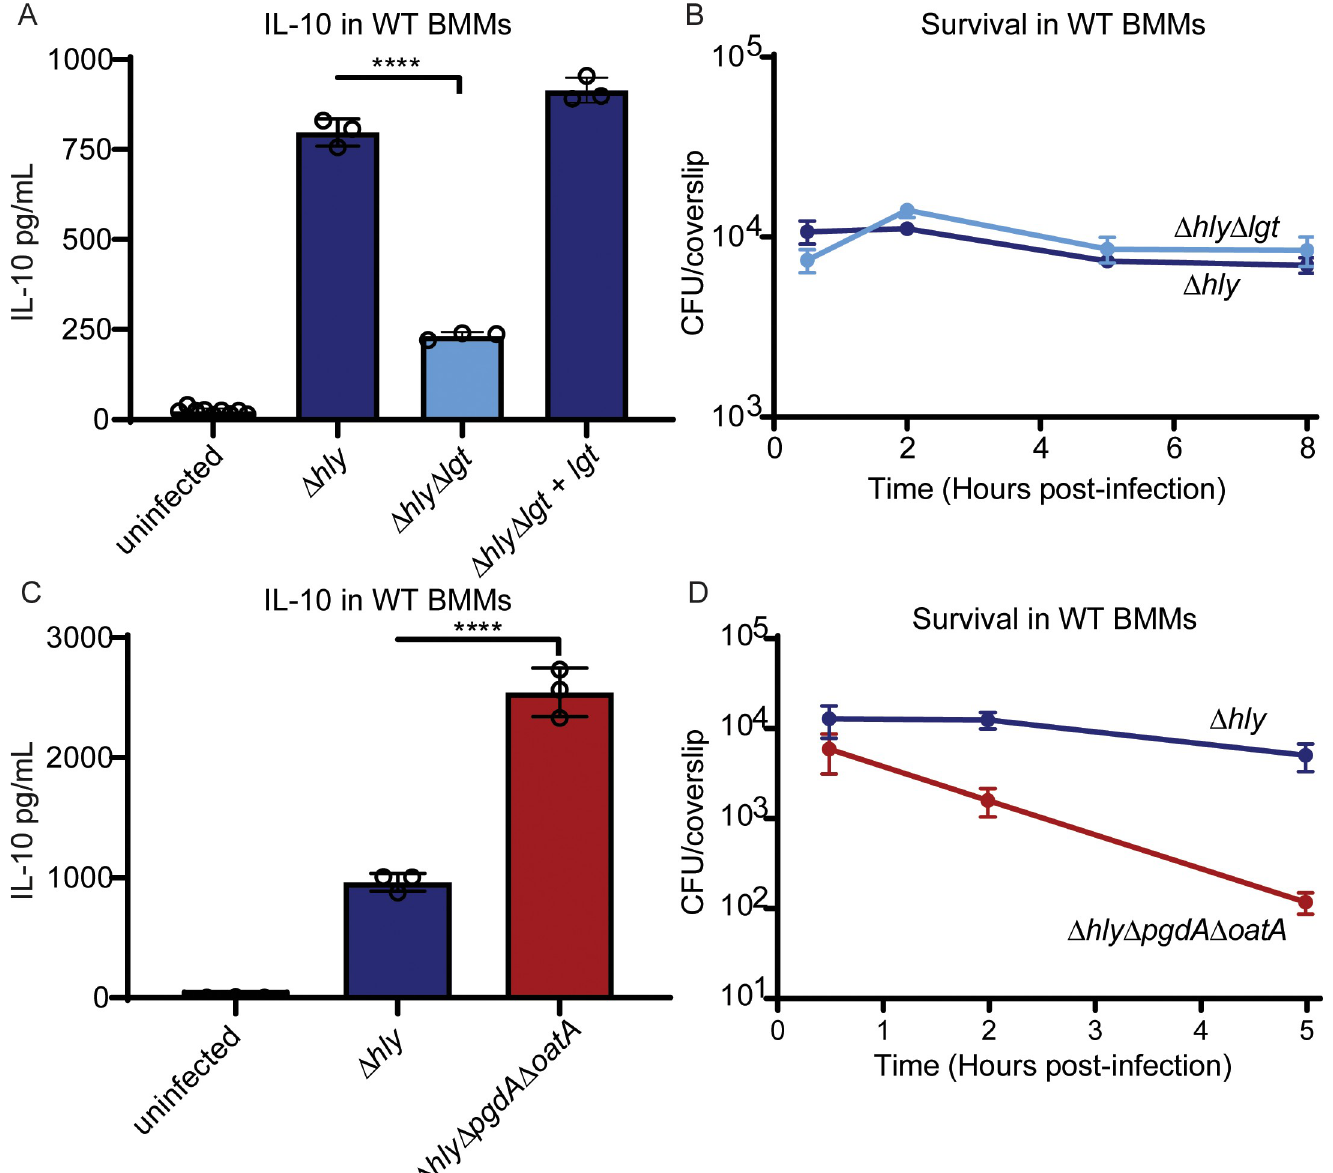
Fig 2. Induction of IL-10 is mediated by lipoproteins and bacteriolysis. (A) IL-10 secretion from BMMs four hours-post infection. Mean and SD are shown. Data are representative of two independent experiments. Data analyzed using Holm-Sidak’s multiple comparison’s test. (B) Survival of lgt deletion mutant in BMMs. Data is representative of two independent experiments. Mean and SEM are shown. (C) IL-10 secretion from BMMs four hours-post infection. Mean and SD are shown. Data are representative of three independent experiments. Data analyzed using Holm-Sidak’s multiple comparison’s test. (D) Survival of Δ hly Δ pgdA Δ oatA mutant in BMMs. Data are pooled from three independent experiments. Mean and SEM are